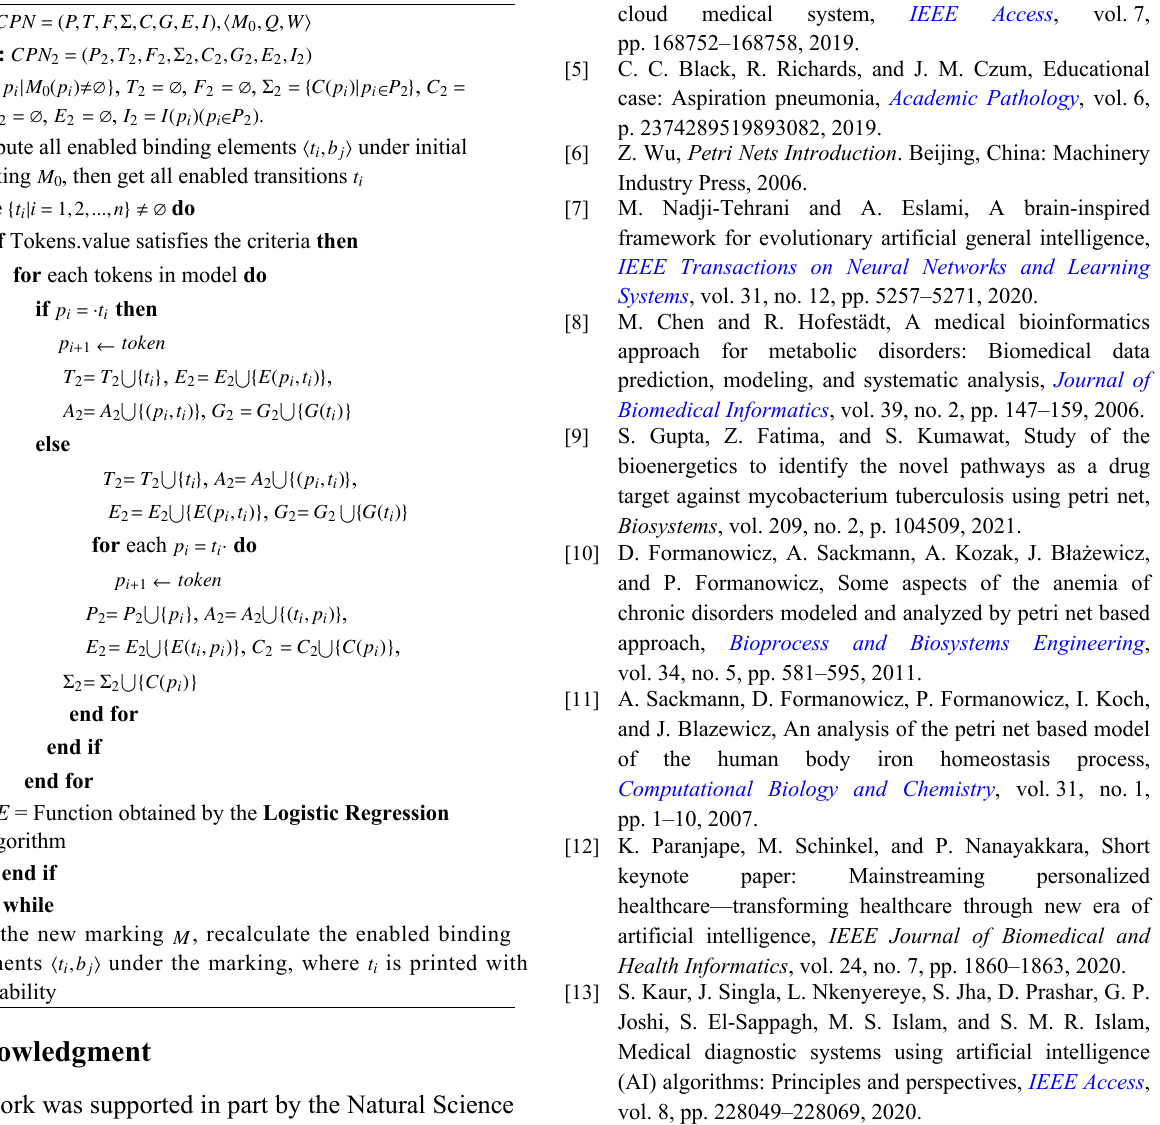
Algorithm 1 Analysis of multiple pathogenic